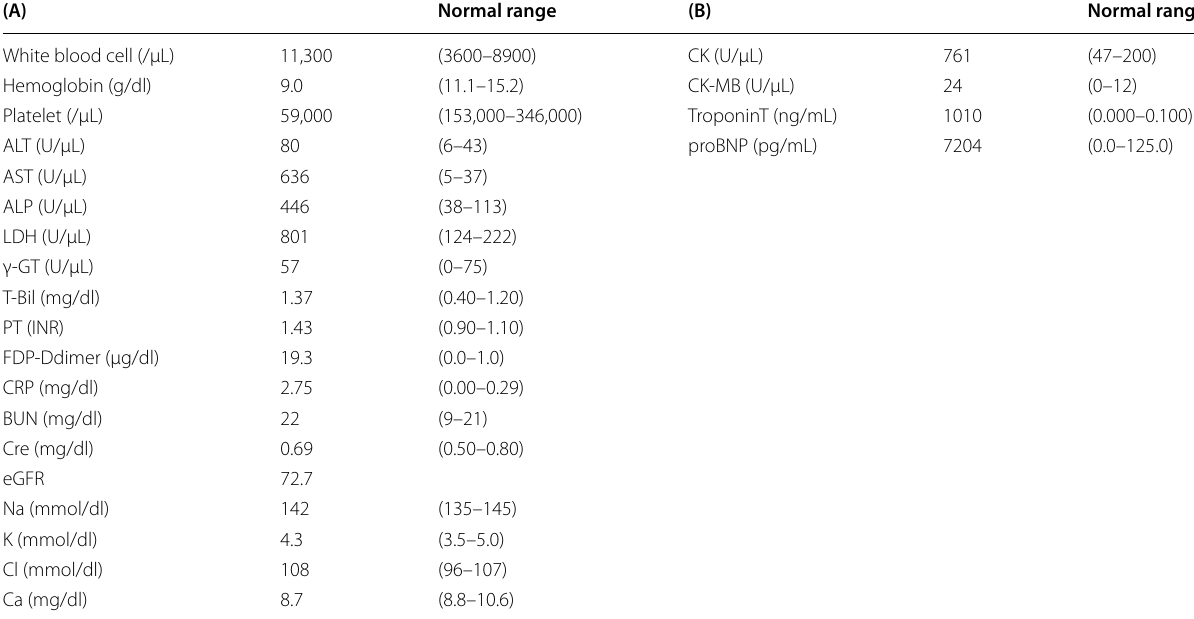
Table 1 Blood test